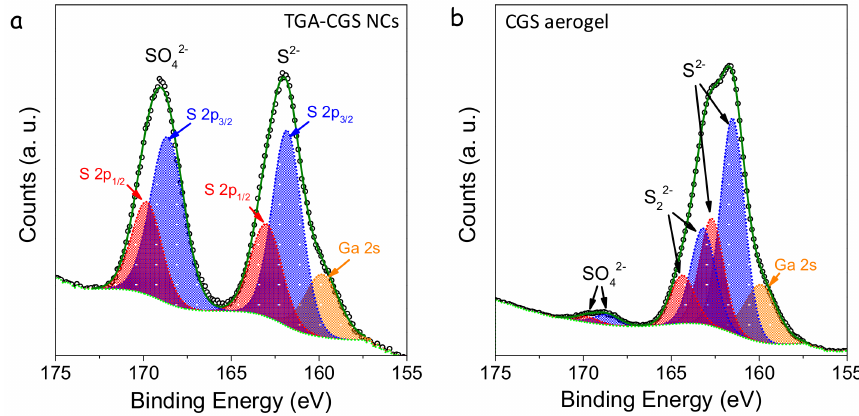
Figure 6. S 2p region of the XPS spectra of the TGA-CGS NCs ( a) and the CGS NC-based aerogel ( b ). S 2p3/2 states are plotted in blue and S 2p1/2 states in red. In the same region, the Ga 2s state is